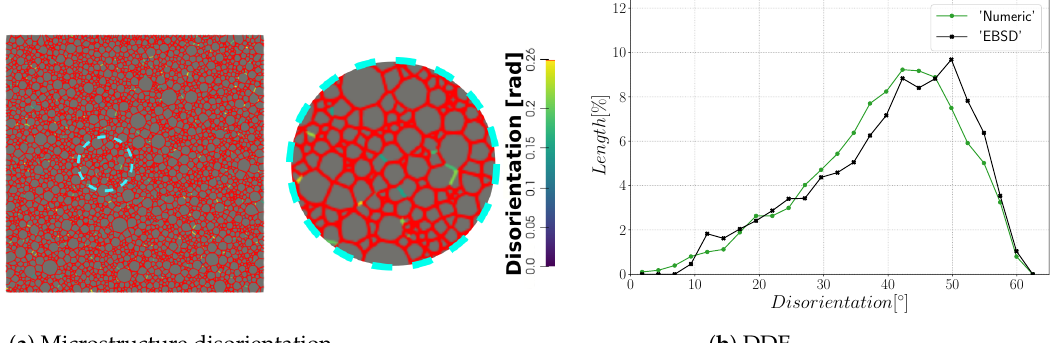
Figure 8. Initial ( a ) microstructure disorientation with a cyan circle that represents the zone shown on the right and ( b ) the disorientation